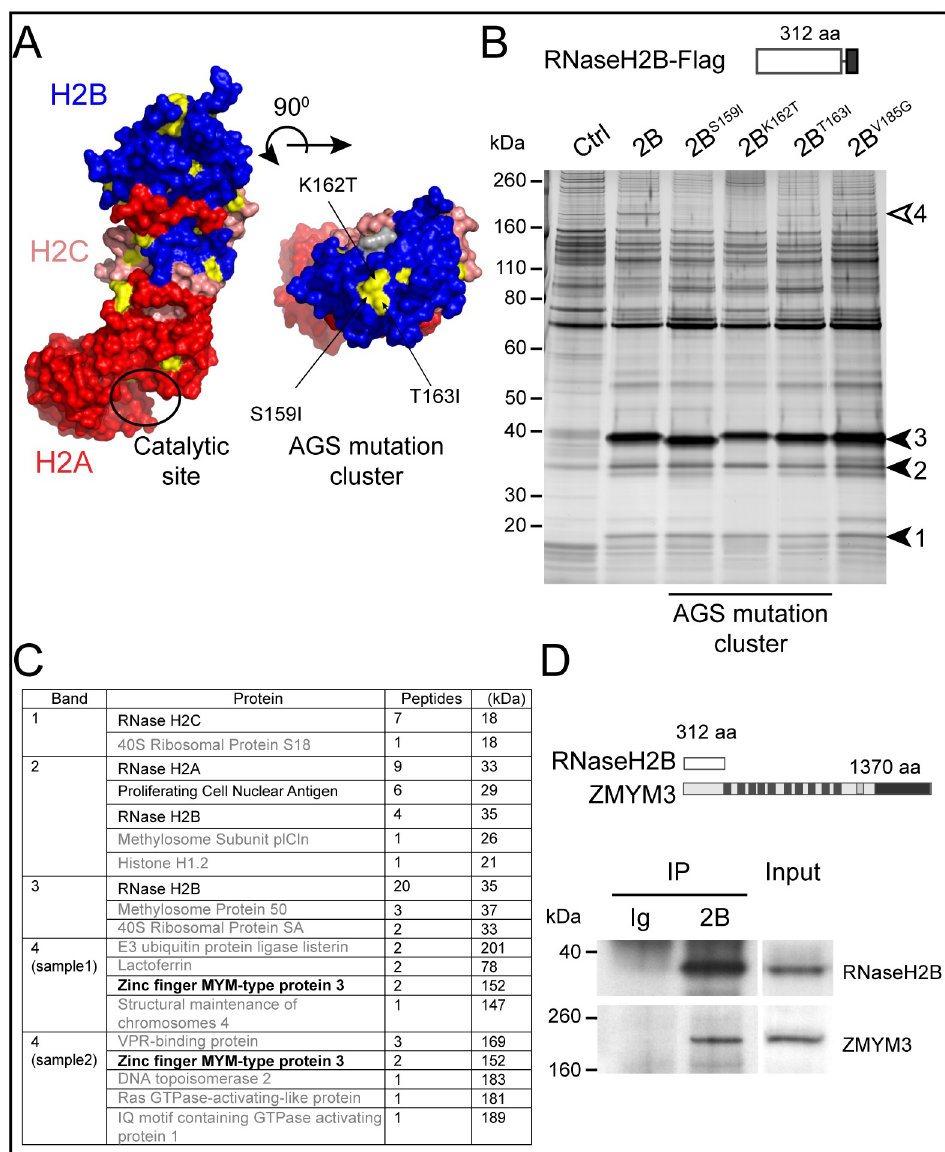
Fig 1. Identification of a novel RNase H2 binding partner ZMYM3. (A) Surface representation of human RNase H2 and location of mutations on the surface of the B subunit. The A, C and B subunits are in red, pink and blue respectively with residues mutated in Aicardi–Gouti è res syndrome shown in yellow and the catalytic site boxed in black. The location of the S159I, K162T and T163I cluster of mutations are indicated on the top view of the structure. Protein Data Bank accession code: 3PUF [14]. (B) Protein complexes associated with wild-type RNase H2B are disrupted by single amino acid substitutions. Pull down of protein complexes associated with RNase H2B-Flag are shown by silver-stained SDS-Page. Lanes correspond to the individual AGS mutations indicated as well wild type (2B) RNase H2B and nonspecific proteins (Ctrl). The closed arrows indicate the RNase H2B subunits. The open arrow indicates a band that is lost in mutant forms of RNase H2. The same result was observed in three independent pull- downs. (C) Peptides identified by mass spectrometric analysis of the regions corresponding to the arrows indicated in (B), ranked by number of peptides identified. Results for the region corresponding to band 4 from two independent pulldowns are listed separately. The most abundant peptides correspond to the RNase H2 subunits and known associated proteins such as PCNA (in black). The common protein identified in band 4 corresponds to the zinc finger MYM-type protein 3 (bold). (D) Endogenous untagged ZMYM3 is associated with endogenous RNase H2B. The schematic representation indicates the protein size in amino acids (aa). Rabbit anti-RNase H2B immunoprecipitaes from HEK293T cell lysates compared control rabbit IgG from serum. The same result was observed in three independent pull-downs. The input corresponds to ~6% of the lysates used for IP. Rabbit anti-ZMYM3 was